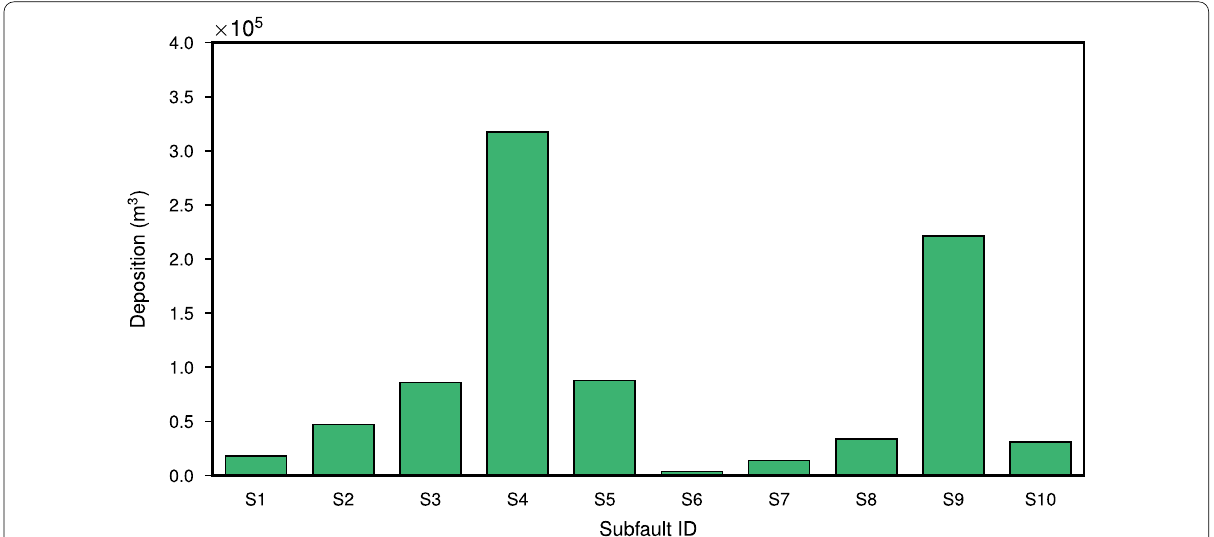
Fig. 3 Deposition associated with the individual subfault models. Uniform slip of 10 m is assumed for each subfault. Whole deposition volume in Domain R6 is